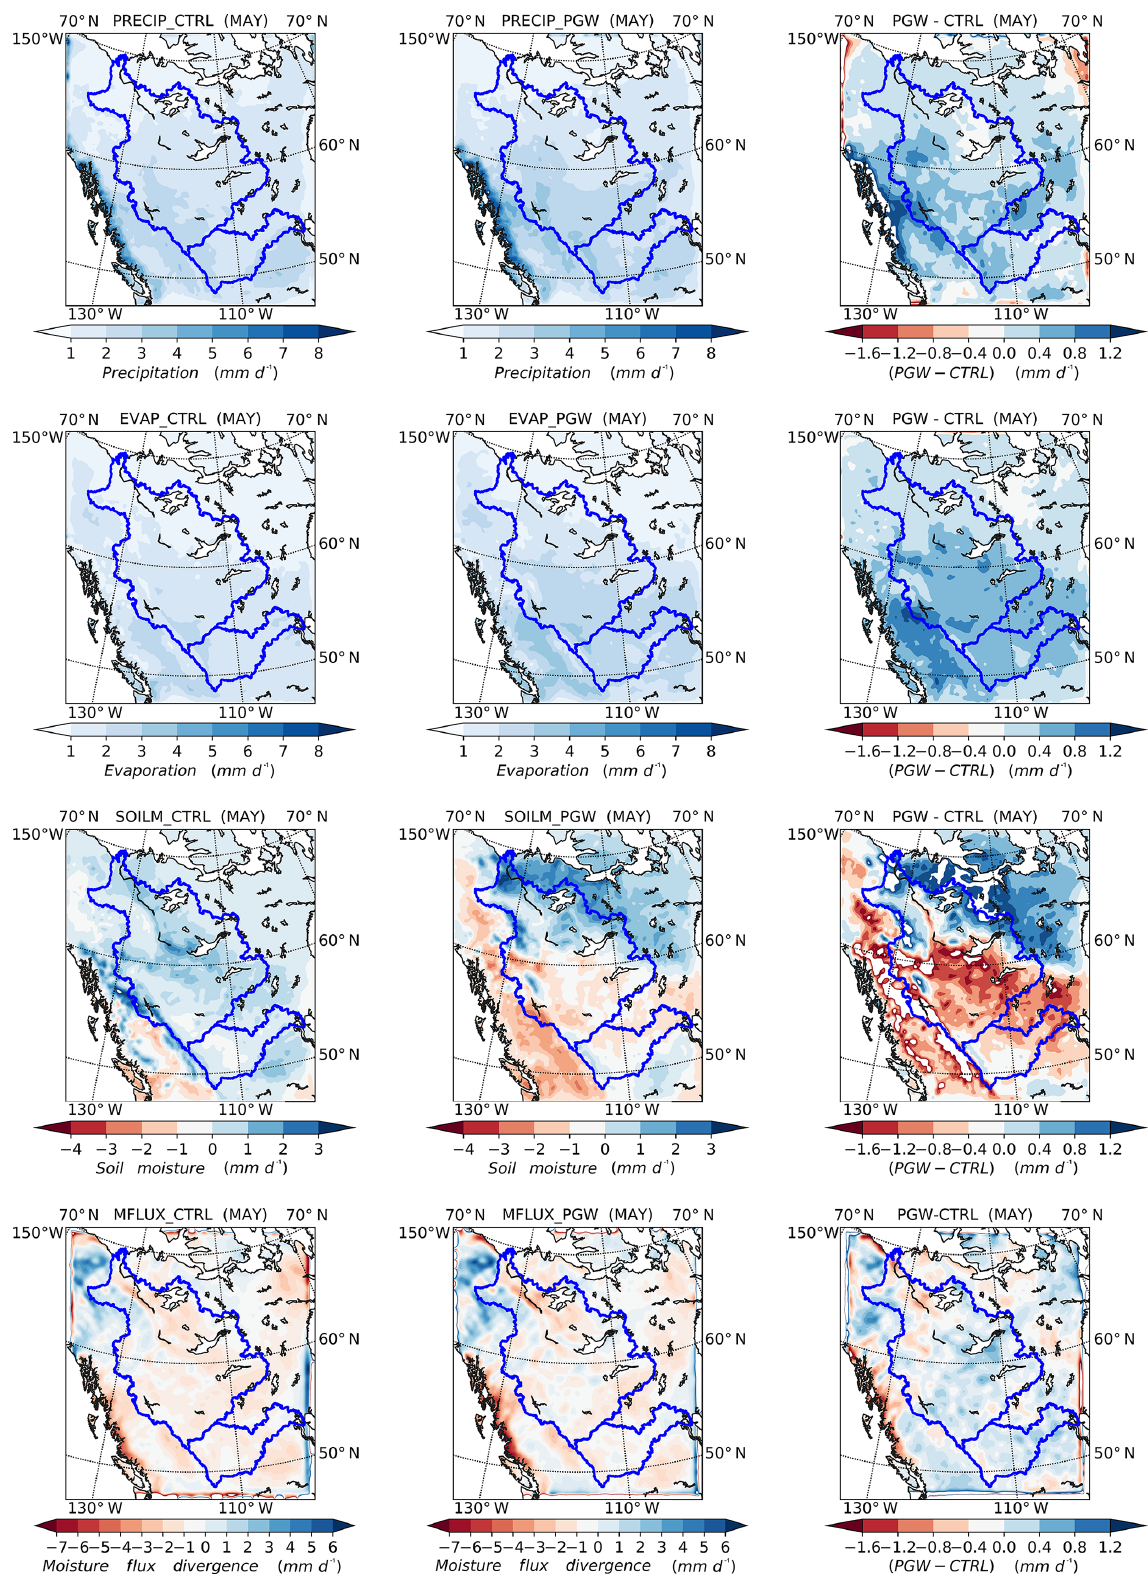
Figure 10. Same as in Fig. 9, except for